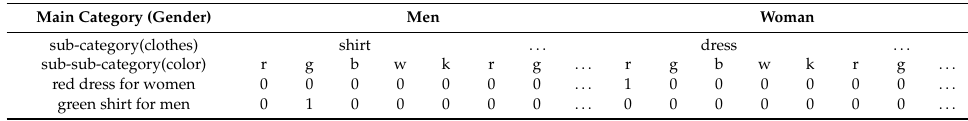
Table 5. Category form-based semantic vector representation for the pre-training. r, g, b, w, and k represent red, green, blue, white and black colors,